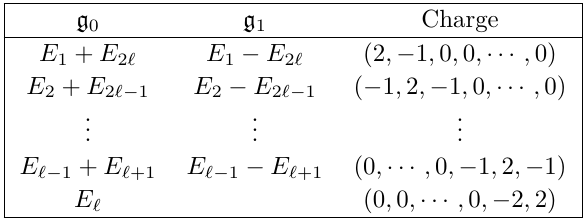
Table 33. Classification of the ladder operators corresponding to the simple roots of A 2 ‘ − 1 under order 2 outer automorphism σ . The charge implies the eigenvalues under the Cartan generators ˜ H i of g 0